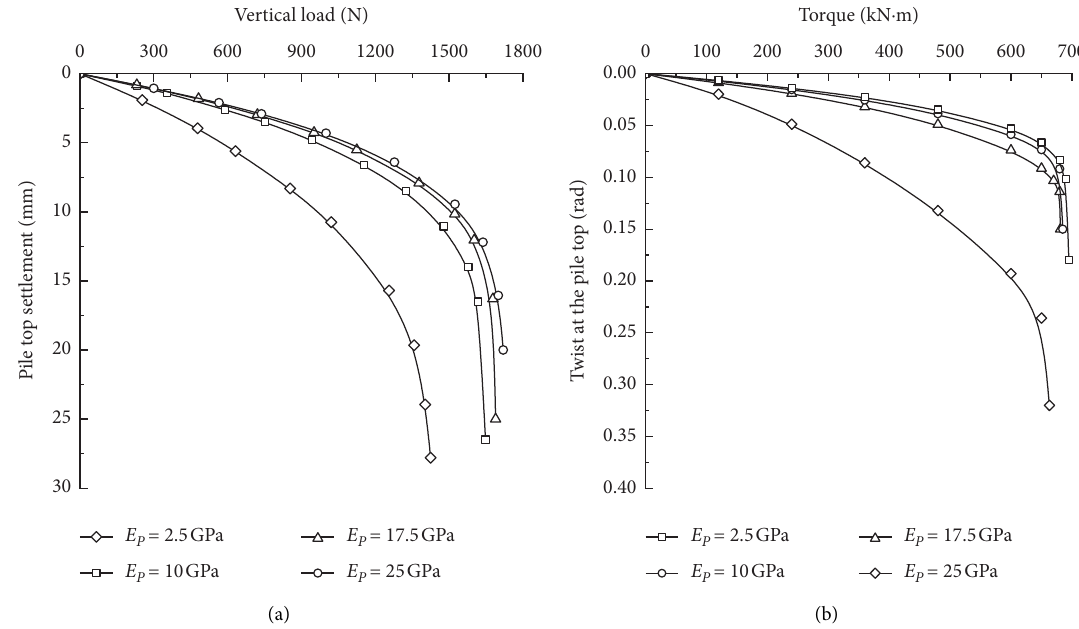
t curve of a single pile under the V ⟶ T